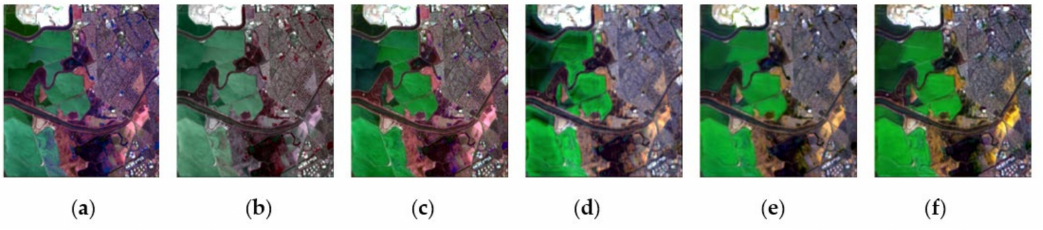
Figure 5. Fused images of San Francisco. ( a ) CNMF; ( b ) JNMF; ( c ) DPLM; ( d ) TCNNF; ( e ) DiCNN; ( f ) CpCNN.